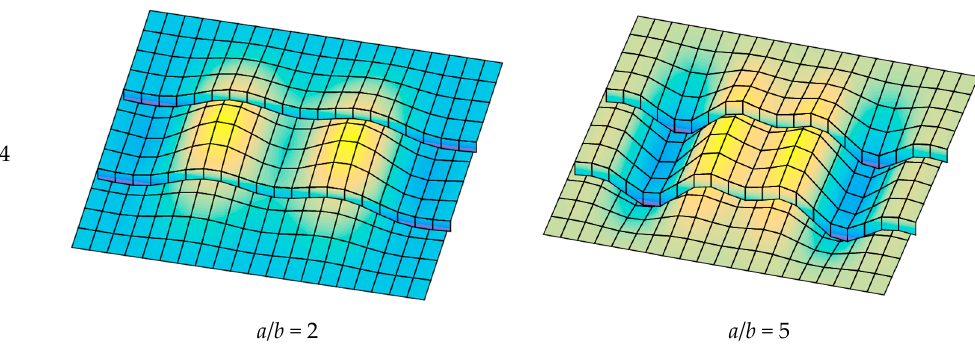
Figure 18. The first four buckling mode shapes of stiffened FGM plate ( b / h = 10, n = 0.5, SSSS, Si 3 N 4 /SUS304).